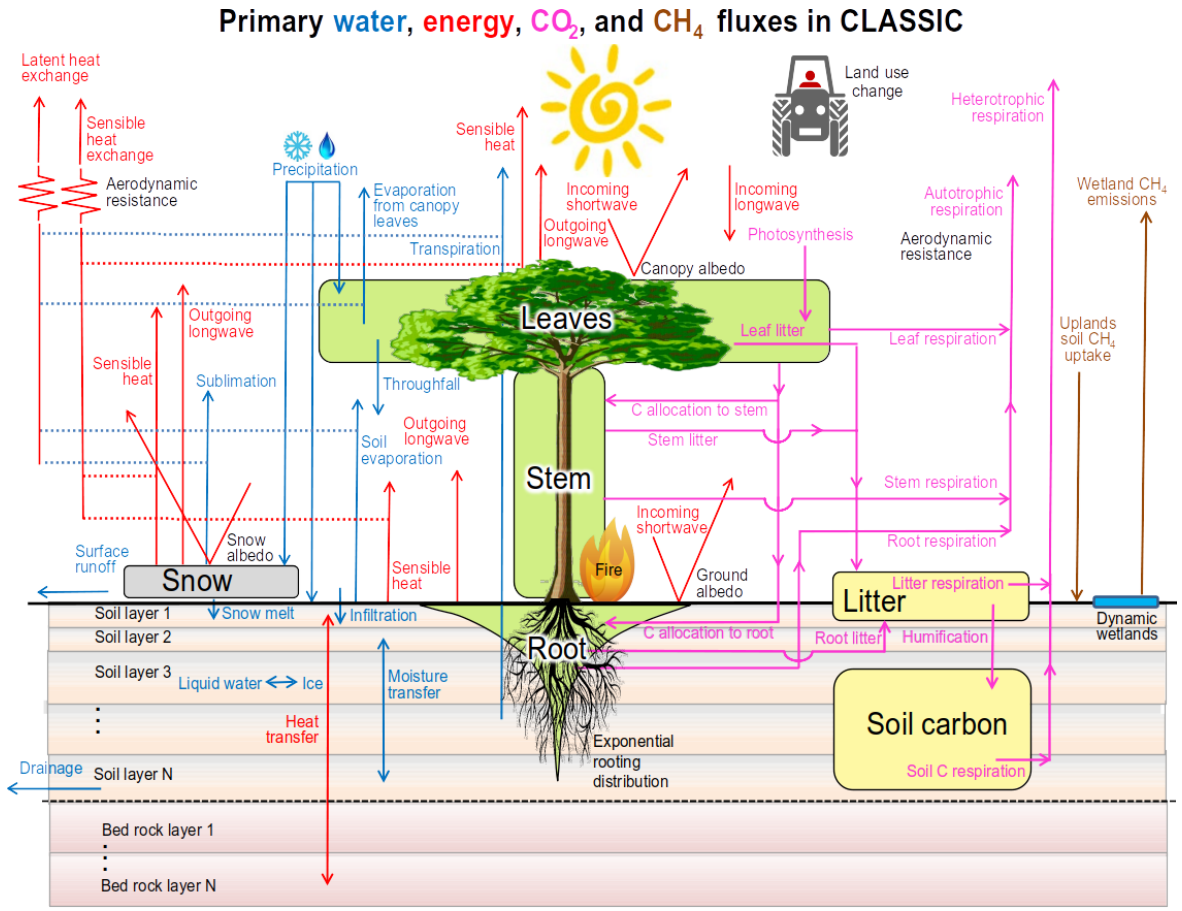
Figure 1. Schematic illustration of processes simulated by